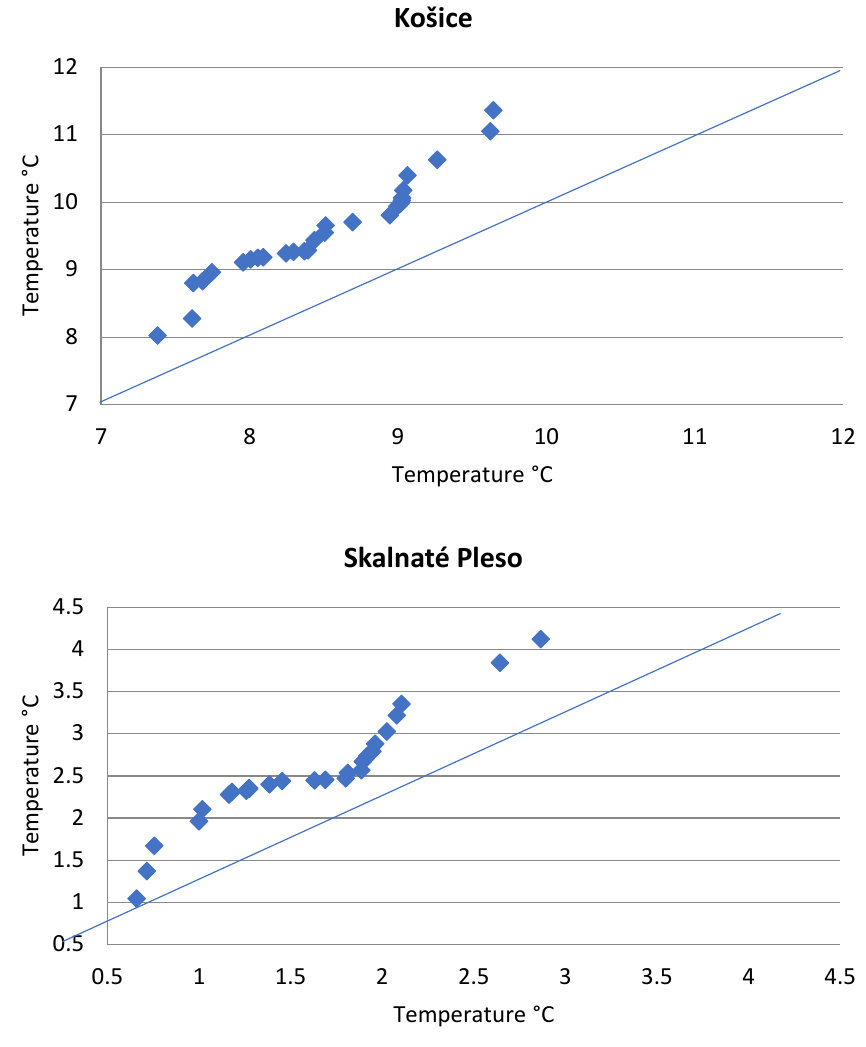
Figure 5. Temperature at Košice and Skalnaté Pleso stations by the Sen trend test.